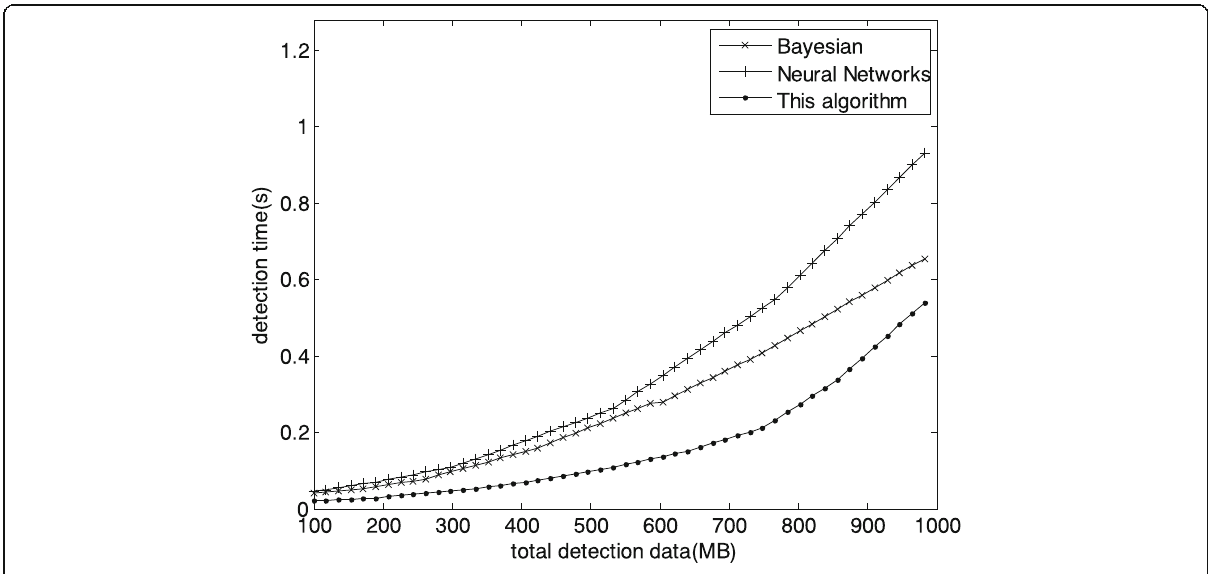
Fig. 1 Overall data size vs. detection efficiency